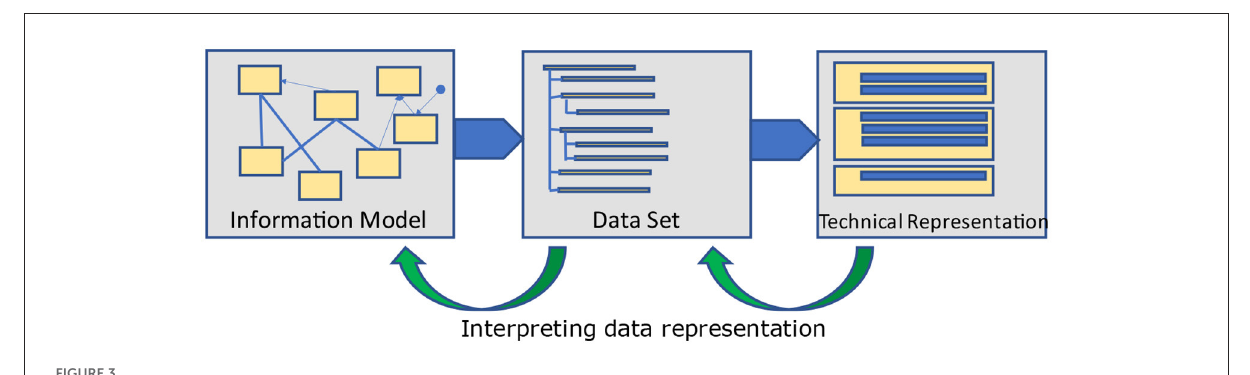
FIGURE2 RM-ODP (18) and ISO/OSI-Stack (24, 25).